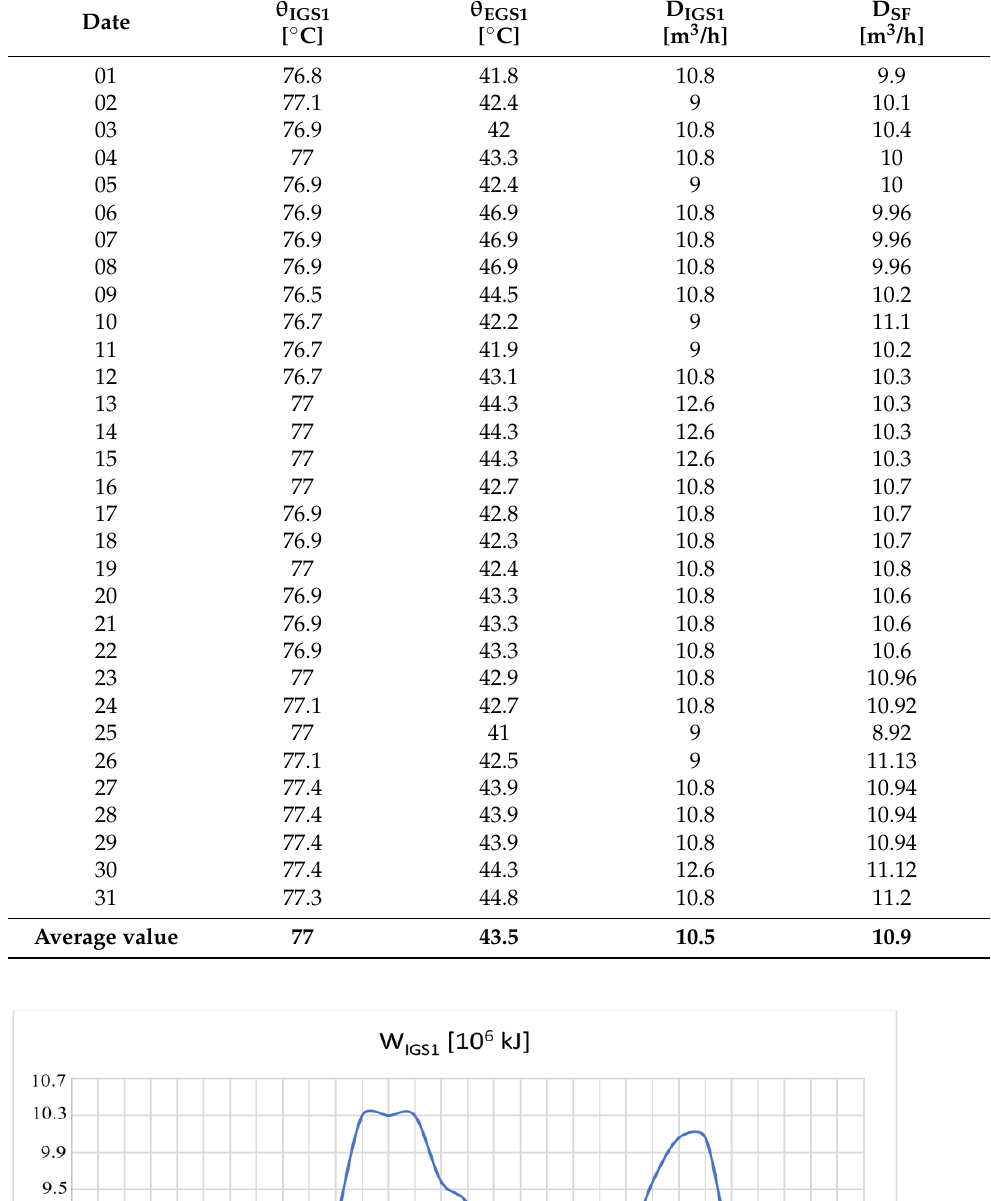
Table 4. Temperatures and flowrates of GTW and SF (DHW) in TS1 [July 2019].